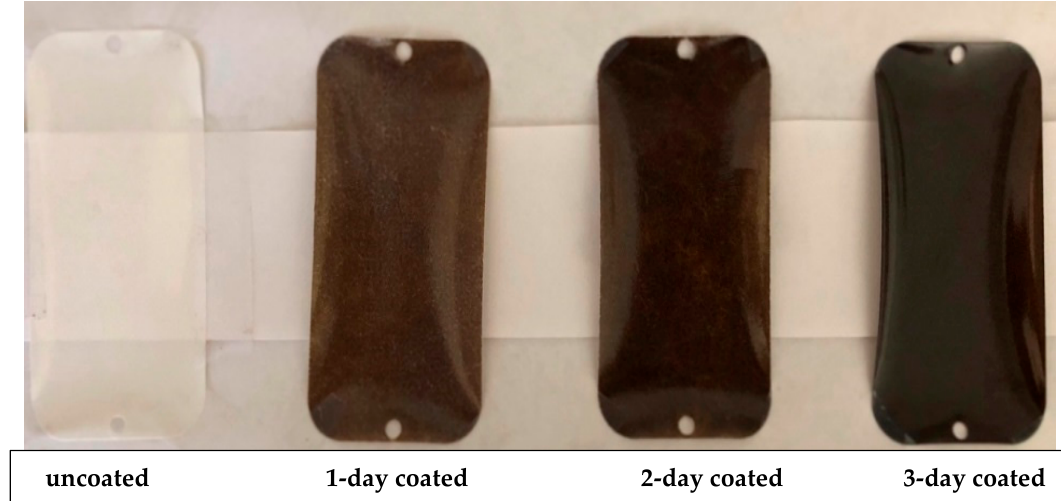
Figure 5. The changes in the colors of the membranes due to coating.